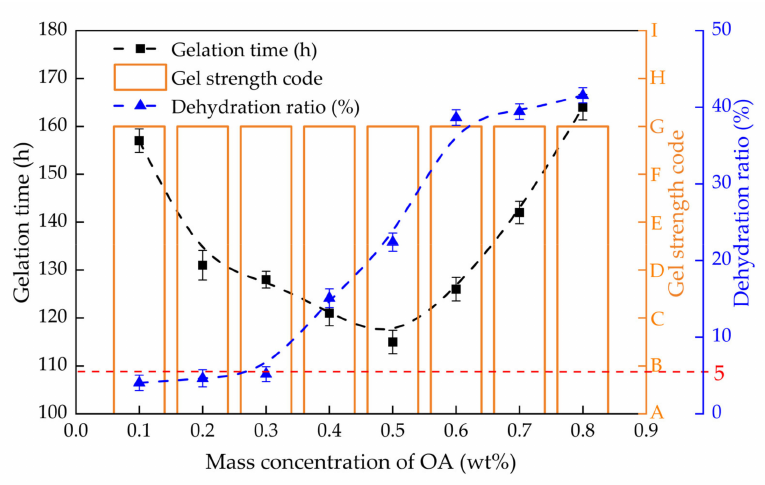
Figure 7. Gelling performance with different concentrations of OA (0.4 wt% PAM + 0.5 wt% HMTA + 0.05 wt%